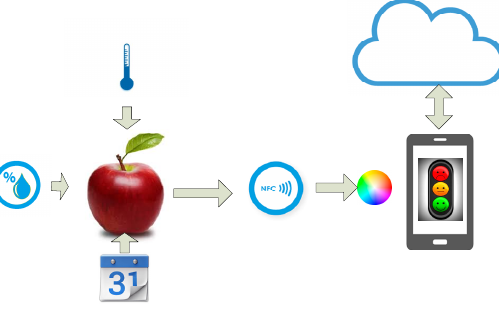
Figure 1. Block diagram of the system.